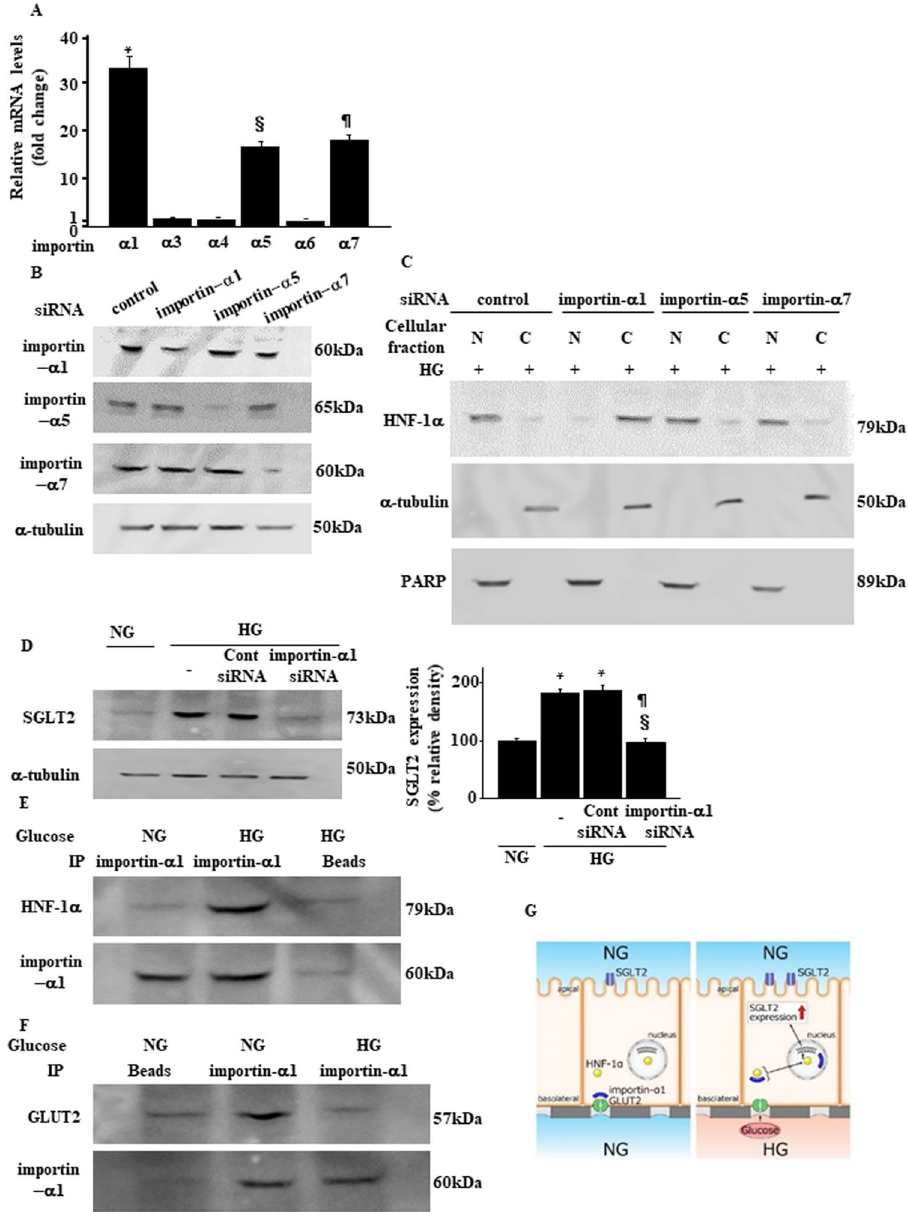
Figure 4. The GLUT2/importin- α 1/HNF-1 α pathway mediates high-glucose-induced SGLT2 expression. ( A ) Quantitative real-time PCR analysis of the relative abundance of mRNAs encoding importins in LLC-PK1 cells. Real-time PCR data were normalized to those of the GAPDH mRNA. Relative fold-differences were calculated using the mean value ( n = 6) of importin- α 6. ( B ) Immunoblotting confirmed the efficiency of siRNA knockdown of each of the representative importin- α isoform that was abundantly expressed in PTs. Results are representative of four independent experiments. ( C ) Subcellular fractionation and immunoblotting analysis of the localization of HNF-1 α . LLC-PK1 cells were transfected with the indicated siRNA duplexes and 48 h later, cells were treated with media containing high glucose levels. Cytoplasmic and nuclear lysates were collected and analyzed using immunoblotting with an anti-HNF-1 α antibody. Results are representative of four independent experiments. ( D ) LLC-PK1 cells were transiently transfected with siRNAs targeting importin- α 1 or a non-targeting control siRNA. Whole cell lysates were prepared 48 h post-transfection and analyzed using immunoblotting. Results are representative of four independent experiments. The bar graph represents the band intensity of each group ( * P < 0.05 vs. NG group and § P < 0.05 vs. HG group , n = 4). ( E , F ) Immunoprecipitation of nuclear extracts from LLC-PK1 cells that were treated with NG or HG. Importin- α 1 formed complexes with HNF-1 α ( E ), whereas it dissociated from GLUT2 ( F ) under HG conditions. Results are representative of four independent experiments. ( G ) Model for the molecular mechanism by which the GLUT2/importin- α 1/ HNF-1 α pathway is involved in HG-induced SGLT2 expression